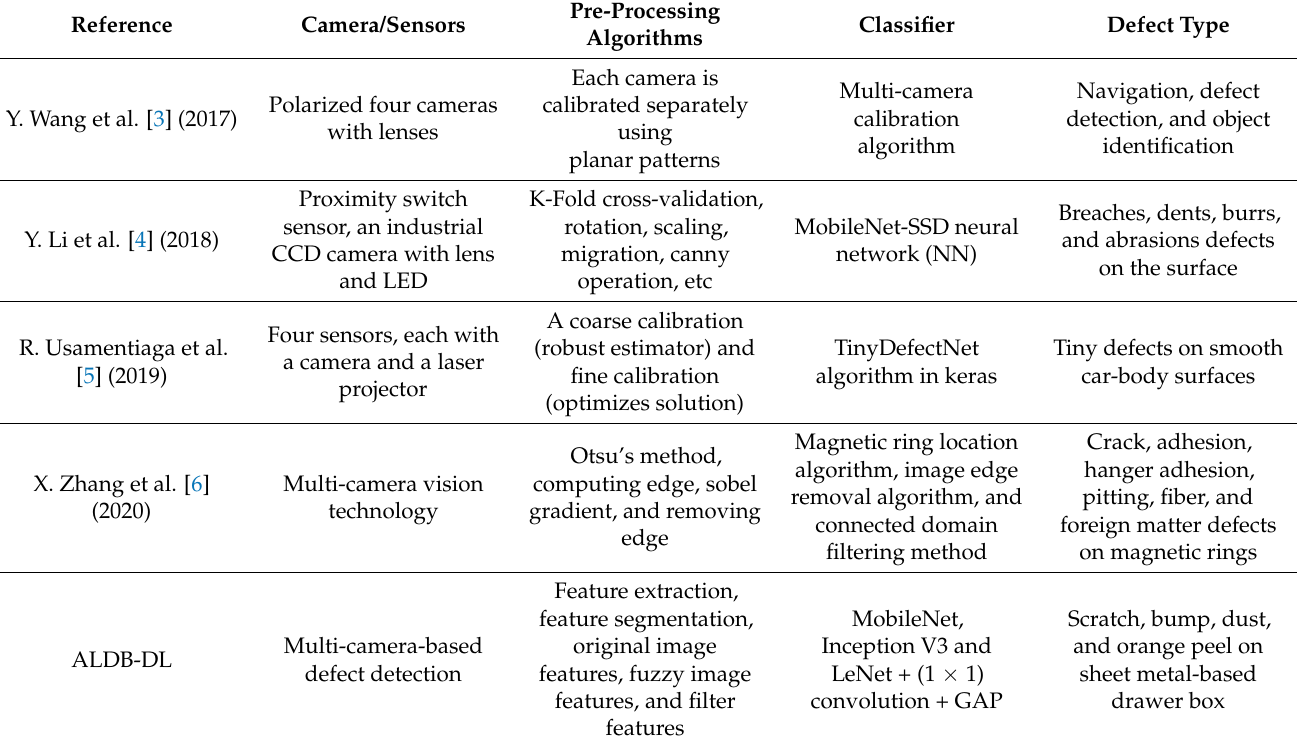
Table 1. Comparison of Defect Detection